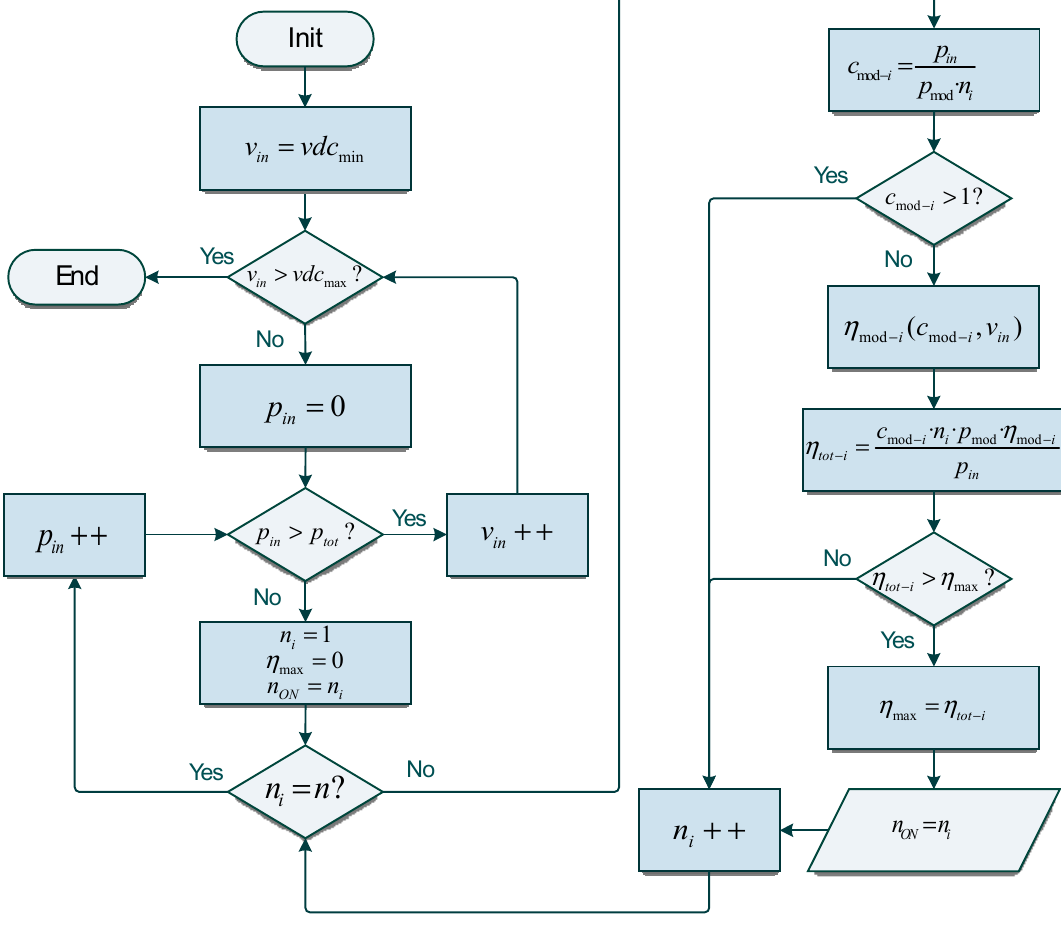
Figure 2. E ffi ciency-oriented Figure 2. Efficiency-oriented algorithm.